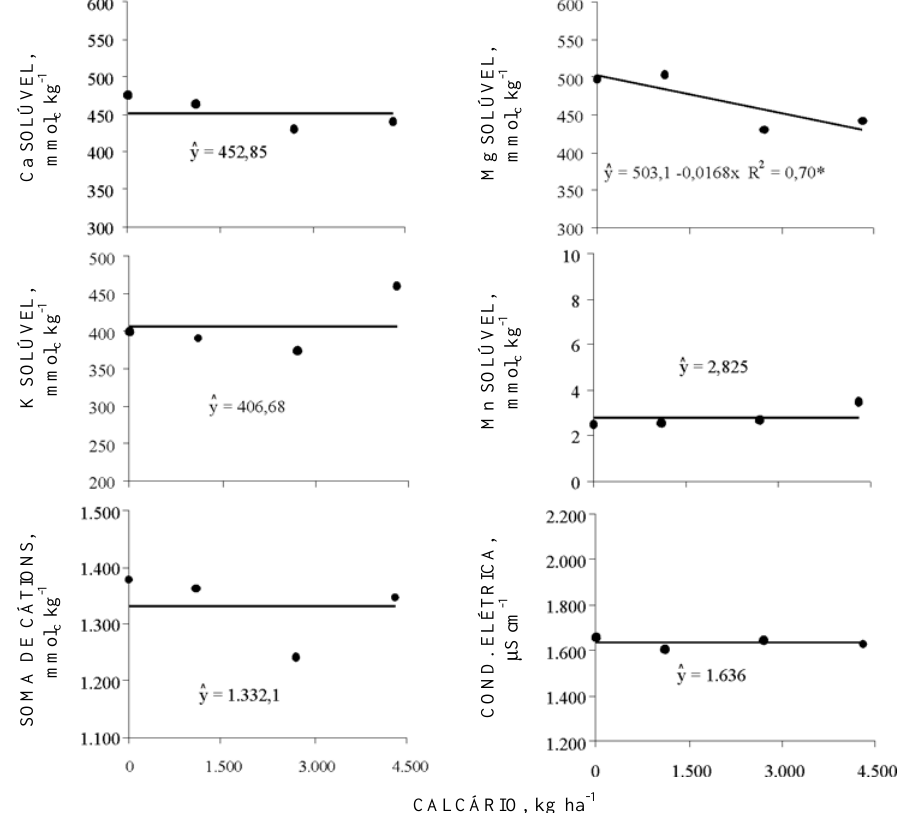
Figura 3. Teores de cátions solúveis nos resíduos vegetais em plantas de cultivares de feijão na época do florescimento e condutividade elétrica do extrato, considerando a aplicação de calcário em superfície. Média de dois cultivares. * e ** significativos a 5 e 1 % pelo teste t.